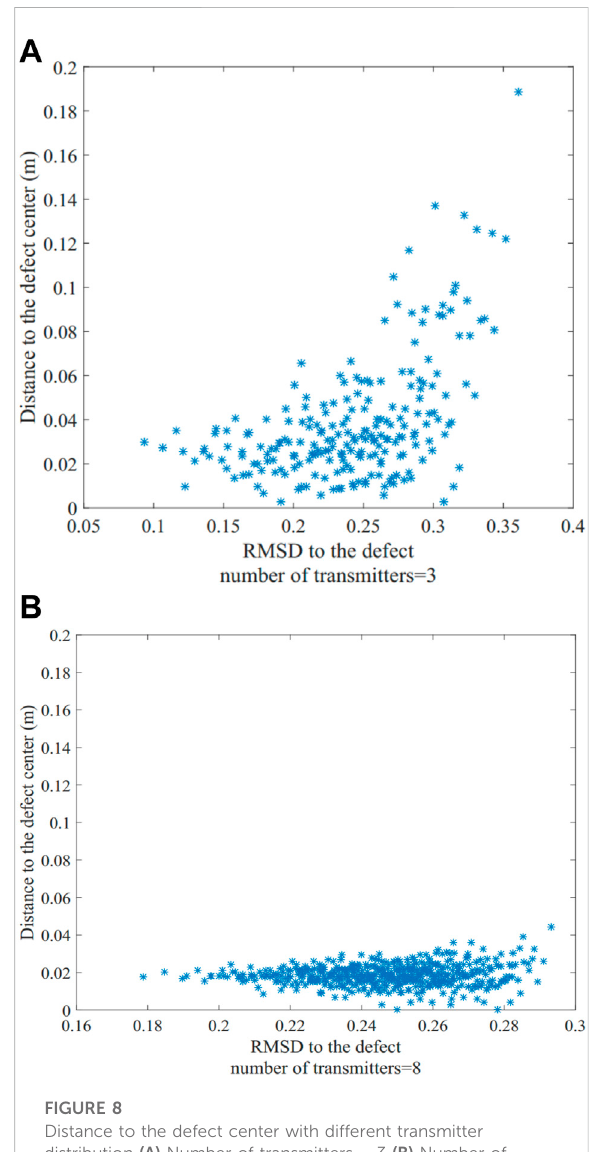
FIGURE 8 Distance to the defect center with different transmitter distribution (A) Number of transmitters = 3 (B) Number of transmitters =